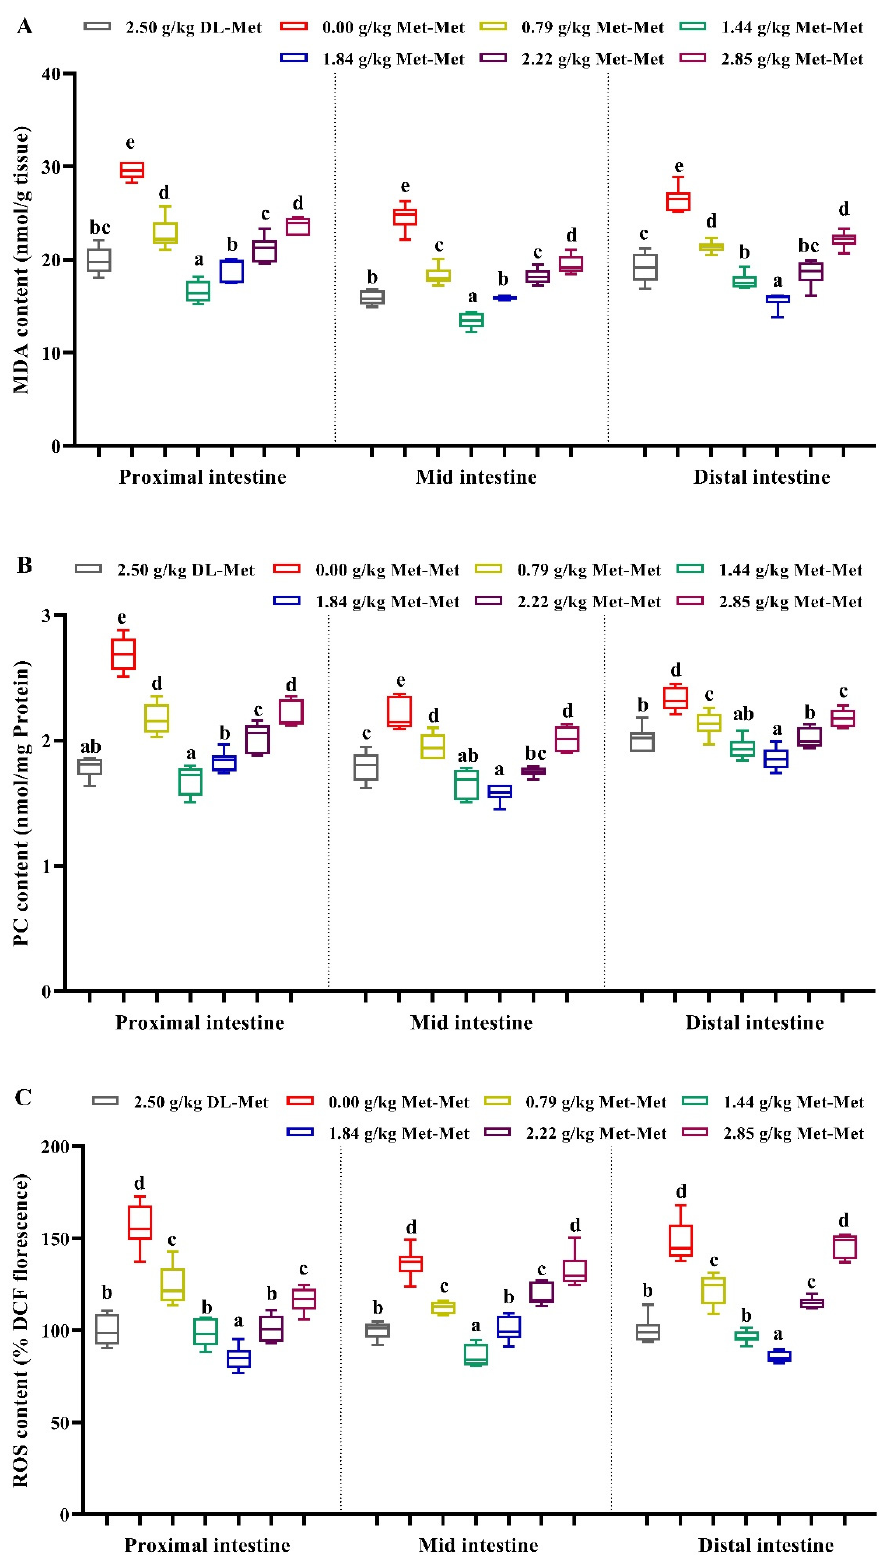
Figure 1. Effects of dietary DL-Met and Met-Met supplementation on malondialdehyde (MDA, ( A )), protein carbonyl (PC, ( B )), and reactive oxygen species (ROS, ( C )) contents in three intestinal segments of juvenile grass carp. Data represent means of six fish in each group, error bars indicate S.D. a, b, c, d, e within a column, means without a common lowercase superscript differ ( p <